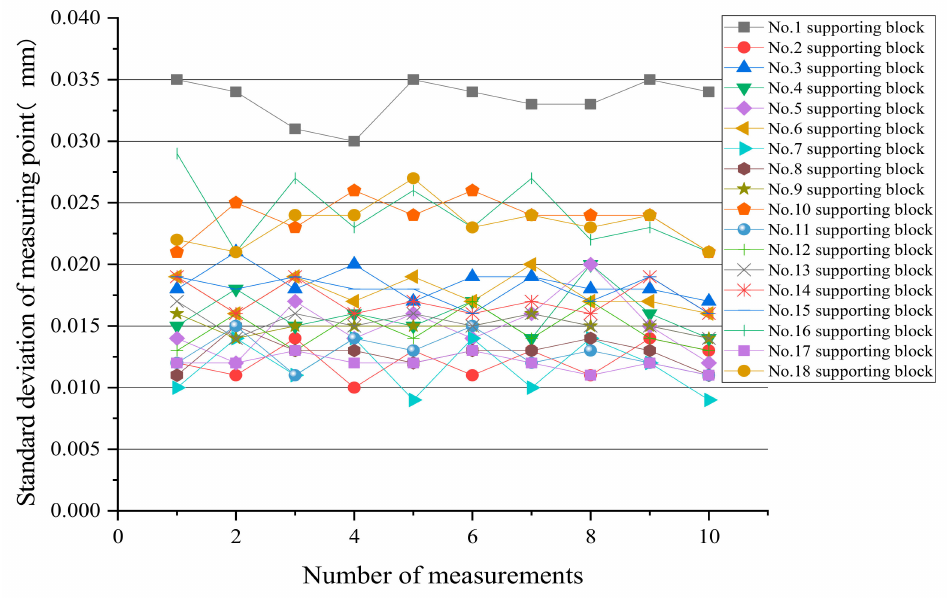
Figure 18. Standard deviation of measuring points for repeated